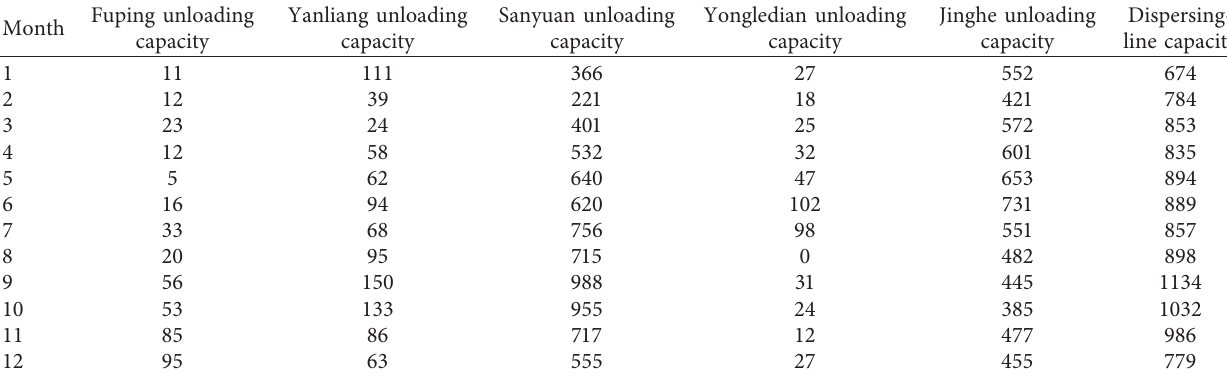
Table 3: Initial statistics of the “dispersion” system in the Tongchuan Depot in 2017.